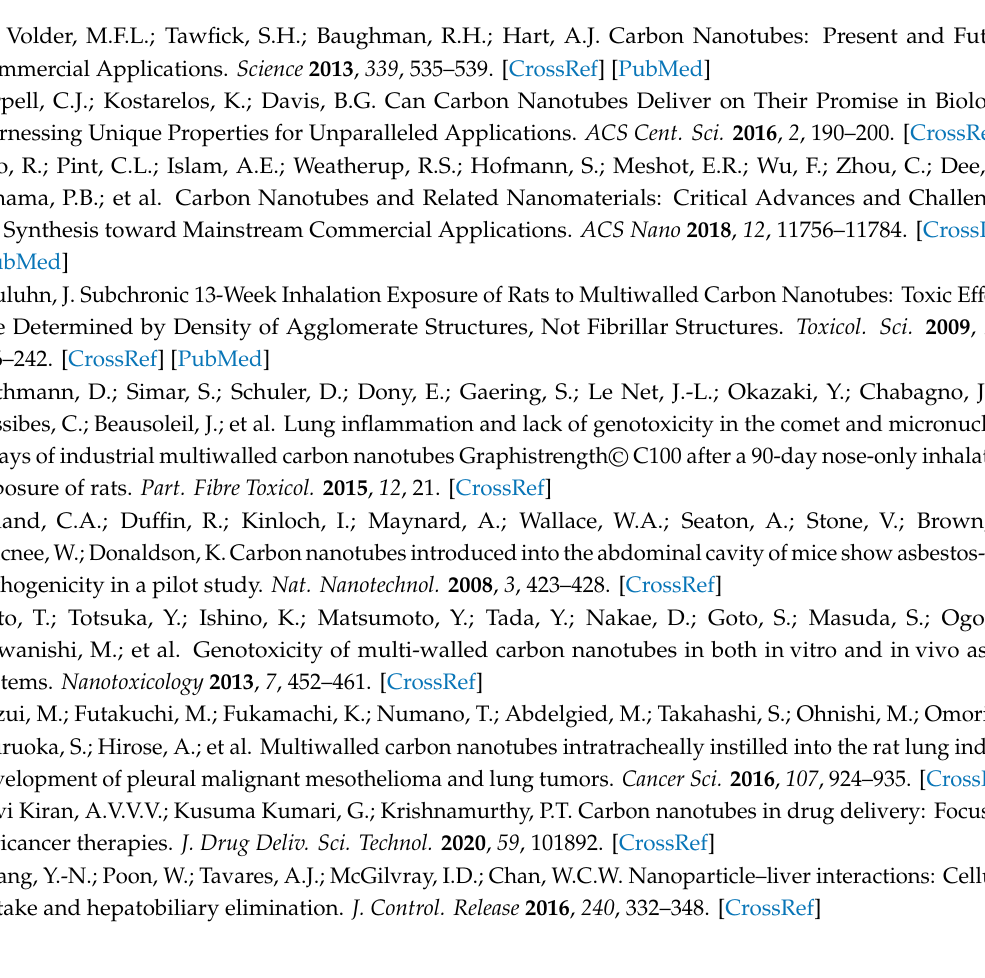
Figure S1: MWNTs induce mild apoptosis in RAW 264.7 cells. Figure S2: Representative 3D video clips of control and C-MWNT-treated RAW 264.7 cells immuno-fluorescent stained for surface SR-A1 receptors. Figure S3: Surface-bound or phagocytosed MWNTs do not interfere with immunofluorescence FCyt assays for surface SR-A1 receptors on RAW 264.7 cells. Figure S4: E ff ects of MWNT accumulation on subsequent phagocytosis of polystyrene beads in WT B6 and MS − / − ZK cells assessed by LSCFM. Figure S5: Fluorescence quenching of fluorescent-conjugated, heat killed E. coli particles by trypan blue dye. Figure S6: Laser scanning confocal Raman microscopy analysis of RAW 264.7 cells with phagocytosed polystyrene beads in the present or absence of C-MWNTs. Figure S7: Reduced oxLDL uptake by RAW 264.7 cells pre-treated with C-MWNTs, but not P- or N-MWNTs, assessed using ORO staining assays. (Directions to access the SI will be updated in the final version of the